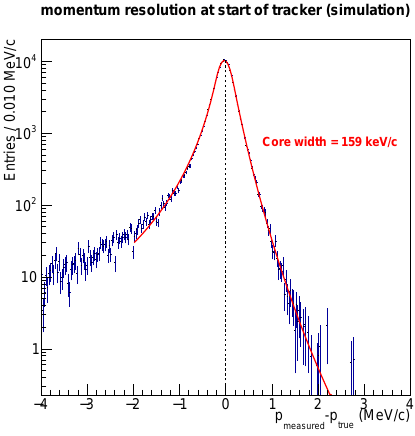
Figure 8. Distribution of the di ff erence between the recon- structed and generated momenta for a CE sample with full Mu2e